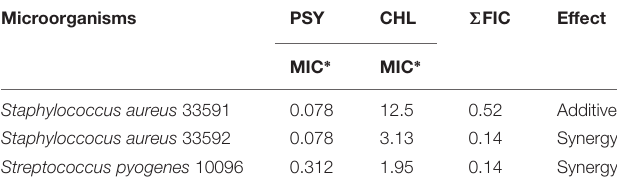
TABLE 2 | Fractional inhibitory concentration (FIC)